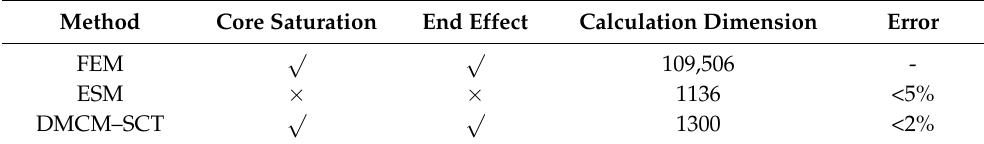
( b ) Figure 15. No-load phase-A output voltage diagram of finite element model and experiment. ( a ) FEM waveform; ( b ) experimental waveform.